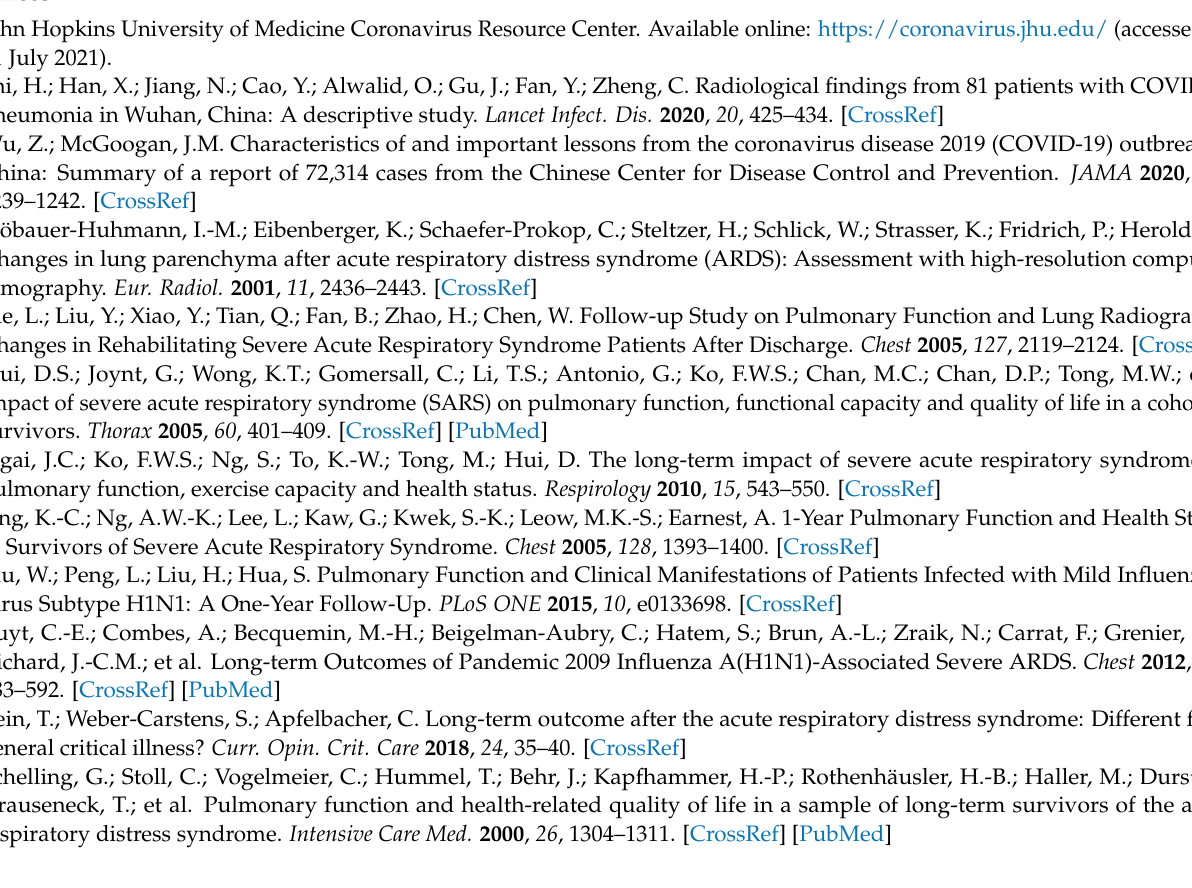
Table S3: Prevalence of pulmonary function abnormalities ≥ 3 months post COVID-19, Table S4: Prevalence of fatigue and respiratory symptoms ≥ 3 months post COVID-19, Table S5: Prevalence of decreases functional capacity and health-related quality of life, and return to work ≥ 3 post COVID- 19, Figure S1: Forest plots for follow-up chest CT, Figure S2: Forest plots for follow-up pulmonary function, Figure S3: Forest plots for follow-up respiratory symptoms, Figure S4: Functional capacity and Health-related quality of